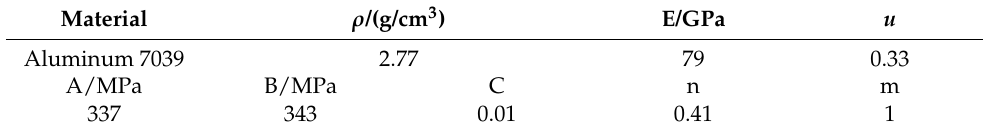
Table 1. Target material parameters.